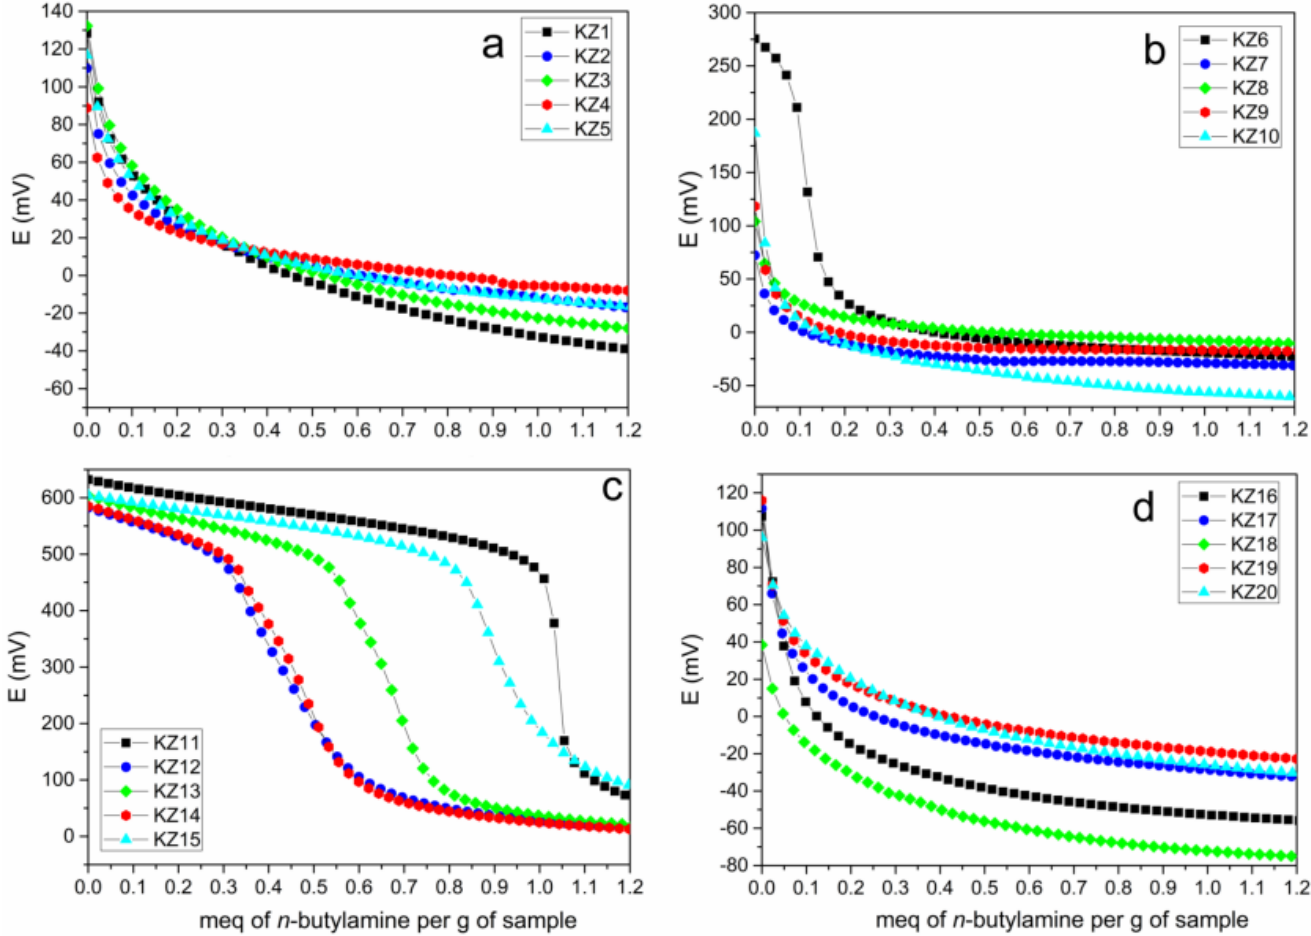
Figure 2. Potentiometric curves of the synthesized solids: ( a ) Acid hydrolysis: acetic acid (KZ1, KZ2, KZ3, KZ4, KZ5); ( b )